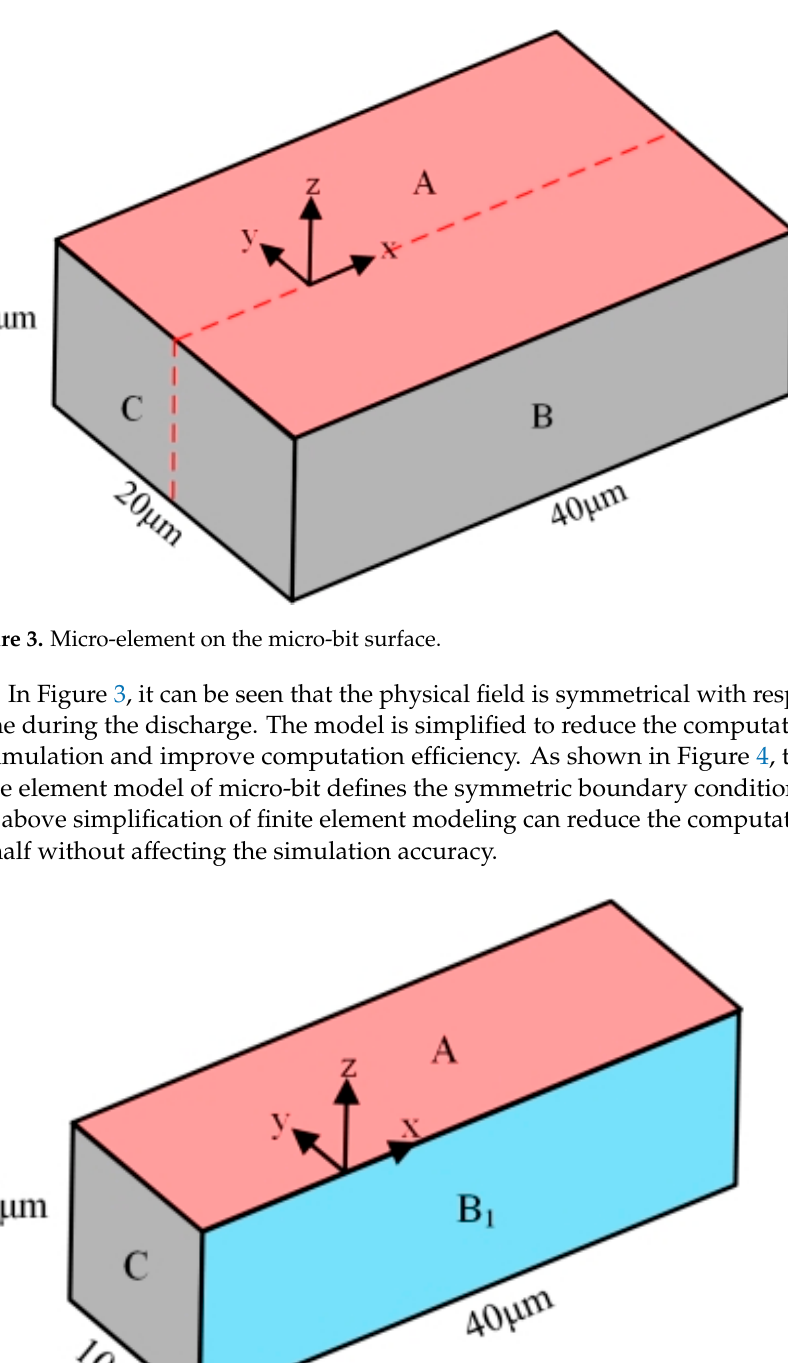
Figure 4. Simplified micro-element on the micro-bit surface.